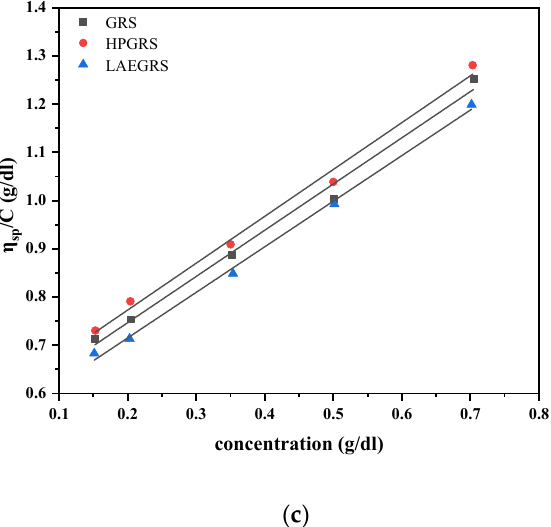
Figure 1. Reduced viscosity values of HPGRS-WS ( a ) at different ratios (HPGRS: WS = 1:99, 3:97, 5:95, 10:90); LAEGRS-WS ( b ) at different ratios (LAEGRS: WS = 1:99, 3:97, 5:95, 10:90); GRS, HPGRS, LAEGRS ( c ).